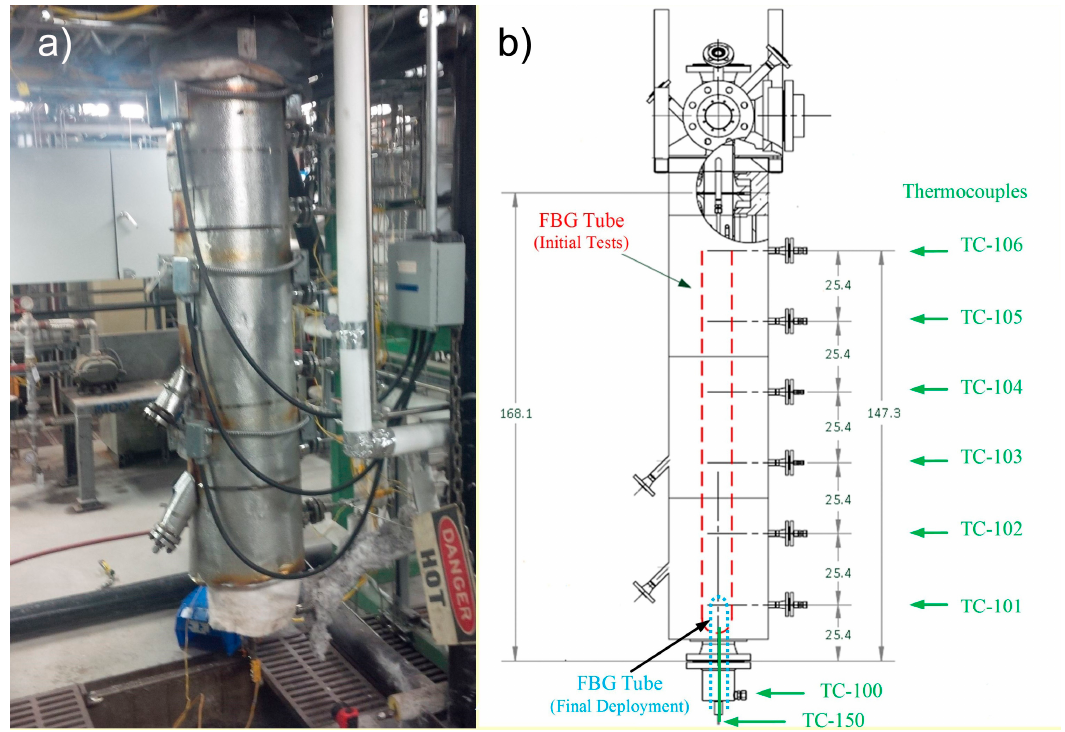
Figure 7. Bottom section of fluidized bed combustor (with insulation). ( a ) Photo, and ( b ) Depiction of internal FBG and thermocouple locations.